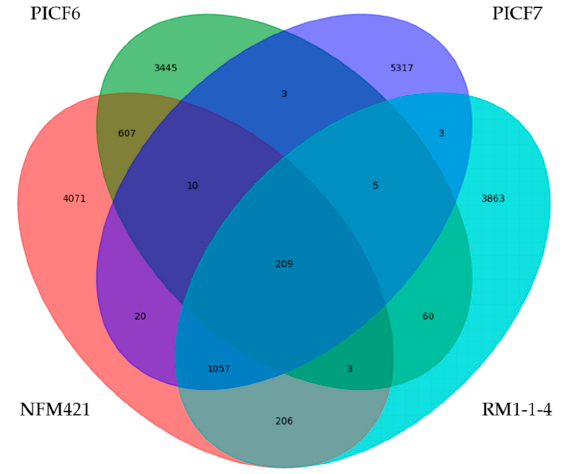
Figure 6. Venn diagram showing the comparison of the full sets of orthologous coding sequences present in the genomes of Pseudomonas sp. PICF6, Pseudomonas brassicacearum NFM421, Pseudomonas corrugata RM1-1-4 and Pseudomonas simiae PICF7. Figures refer to the number of orthologous coding sequences shared or not among the four strains included in the analysis.